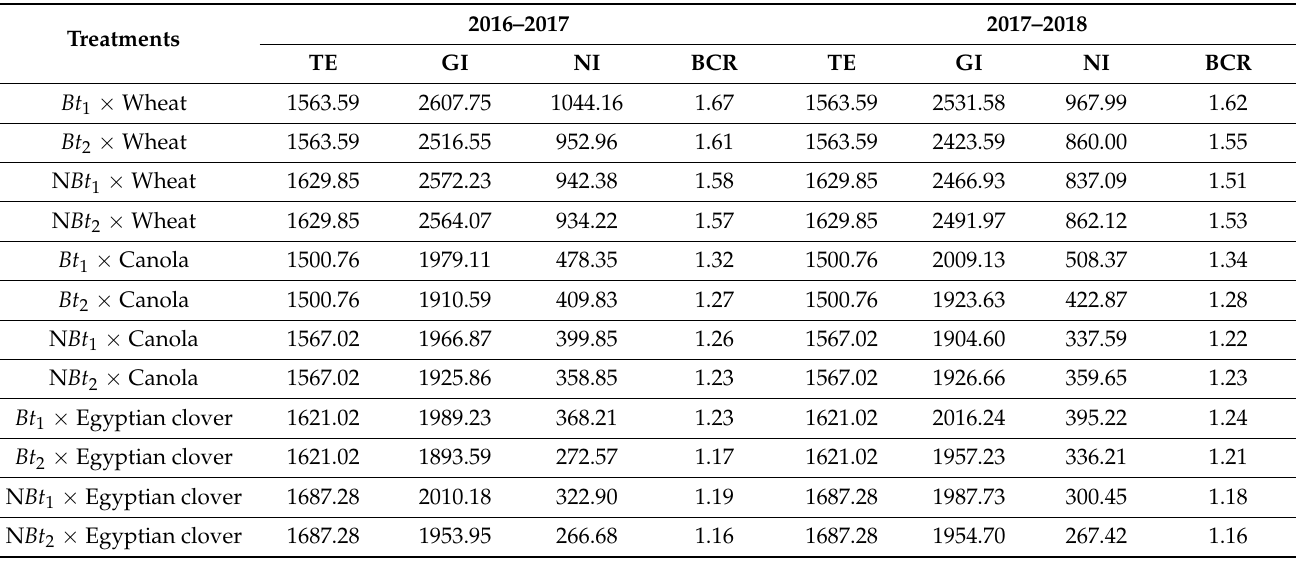
Table 9. The impacts of different transgenic and non-transgenic cotton genotypes on system produc- tivity of various cotton-based cropping